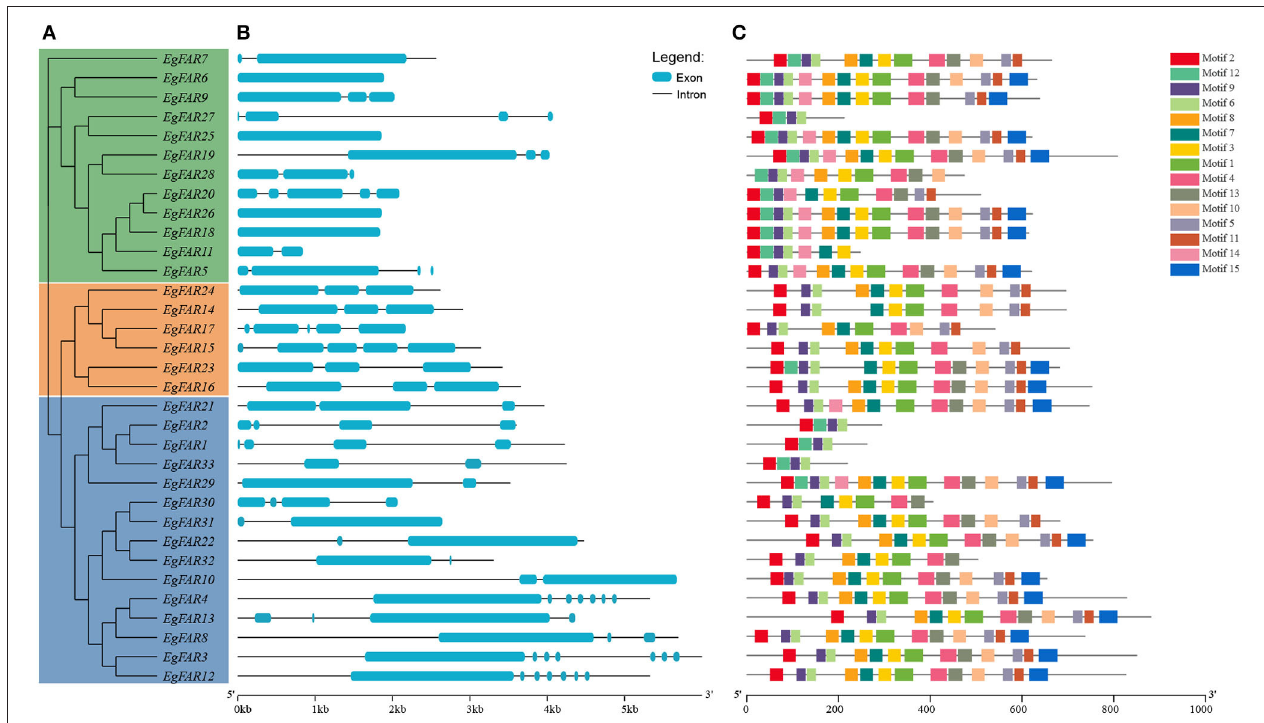
FIGURE 3 | Conserved motifs of FAR1/FHY3 proteins and intron–exon organizations of FAR1/FHY3 genes in Eucalyptus grandis . (A) The phylogenetic tree of FAR1/FHY3 in E. grandis . (B) The intron–exon organizations of FAR1/FHY3 genes. Blue boxes indicate exons; black lines indicate introns. The length of exons and introns for each FAR1/FHY3 gene is proportionally displayed. (C) Conserved motifs of FAR1/FHY3 proteins. Motifs with specific colors can be found on the respective FAR1/FHY3 proteins. The order of the motifs corresponds to their position within individual protein